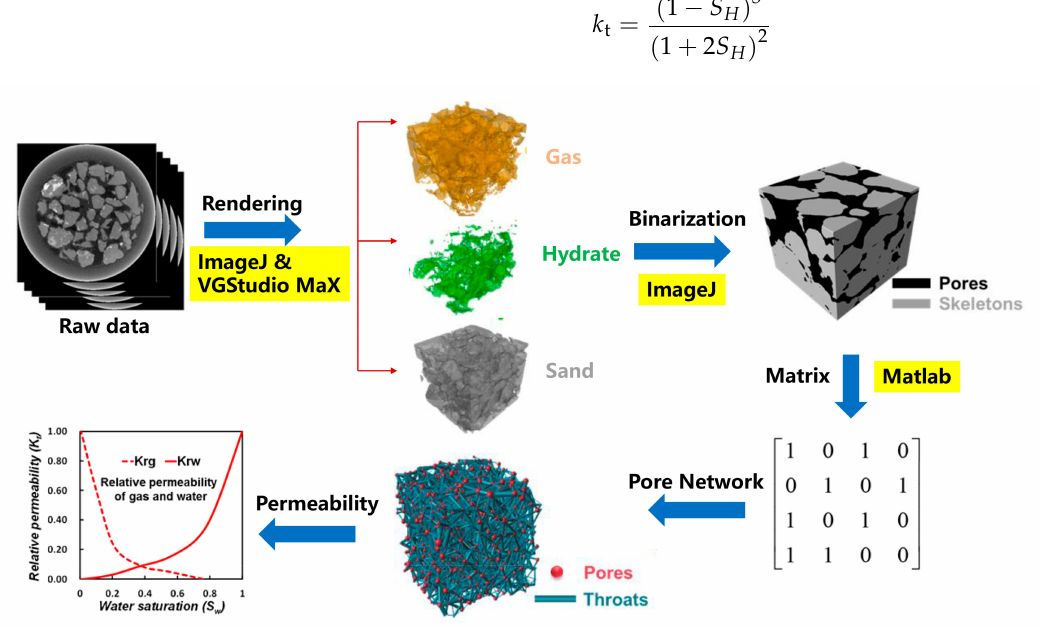
Figure 11. The brief procedure of PNM (every unit from Yang, et al.